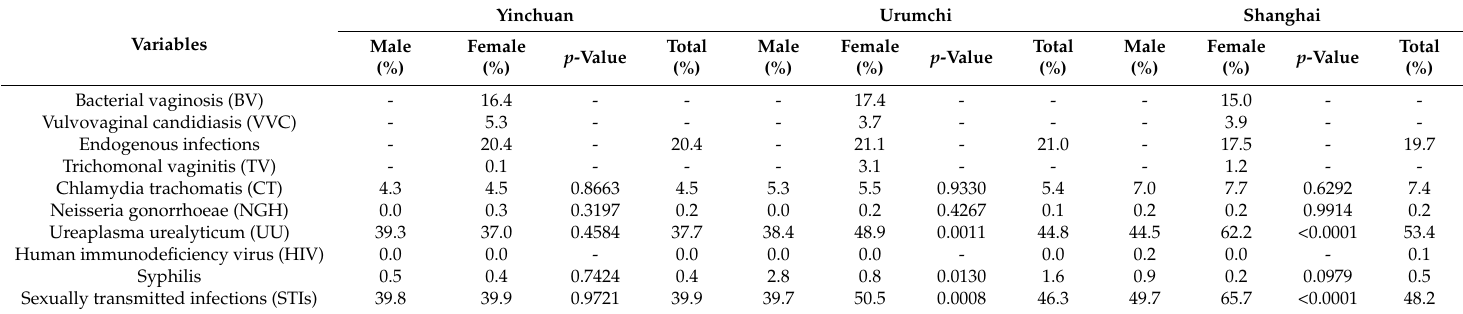
Table 4. Distribution of laboratory-confirmed RTIs among three